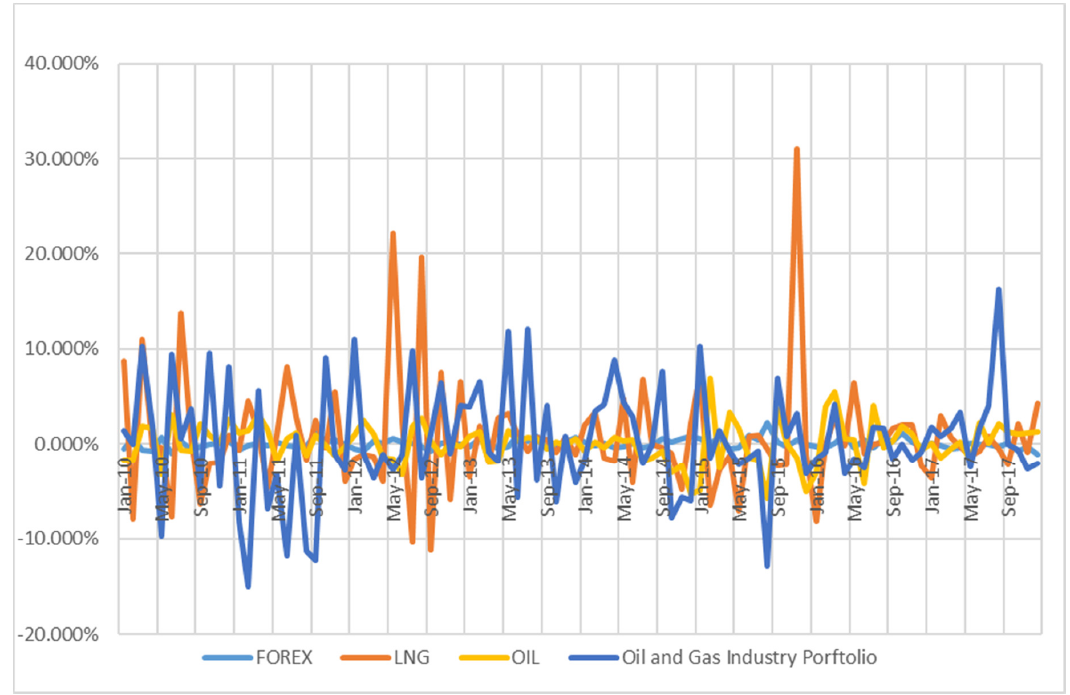
Figure 1. Movements of oil industry portfolio returns with exchange rate, oil, and gas returns.